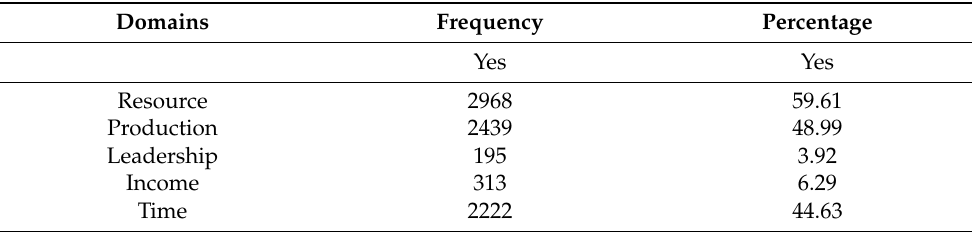
Table 3. Distribution of households according to their empowerment domain.